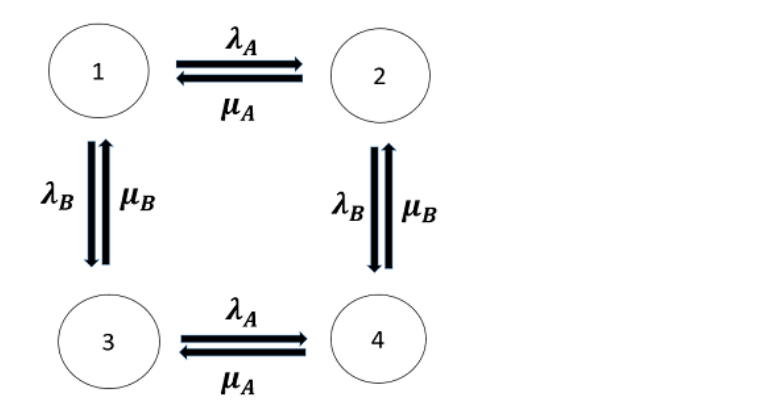
Figure 3. Markov chain of a system of two binary